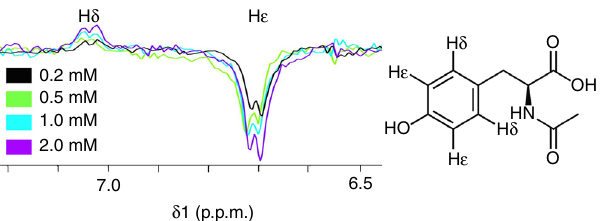
Fig. 3 Uniform illumination of high optical density samples. The intensity of the H ε protons of 5 mM N-Acetyl-L-Tyrosine (AcTyr) are shown for increasing concentrations of photosensitizer (FMN). Above 0.5 mM FMN